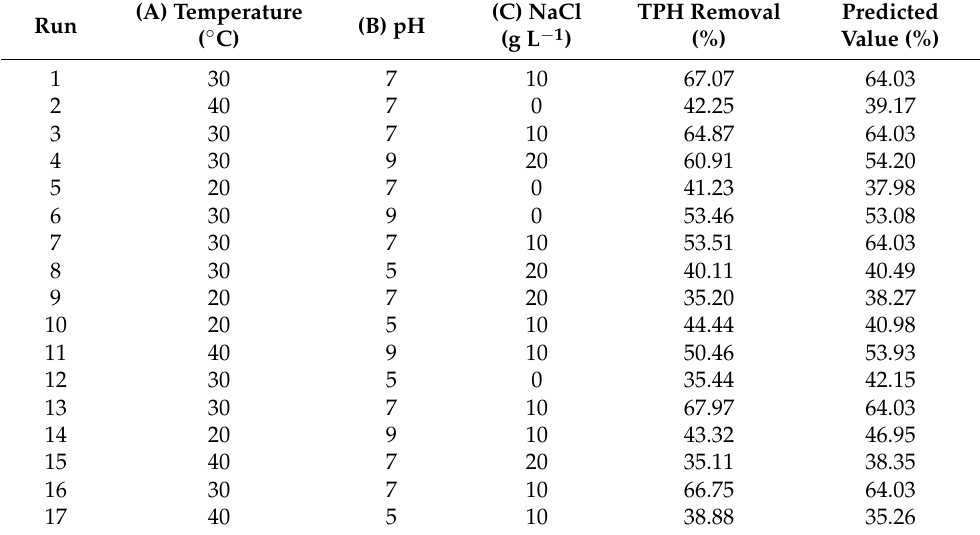
Table 3. Box–Behnken design scheme with the observed and predicted response for TPH